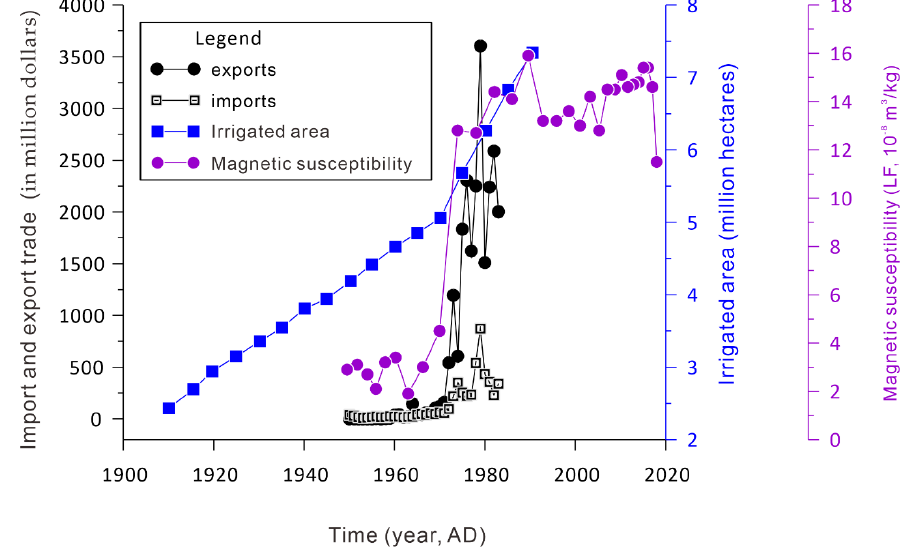
Figure 5. Comparison between sedimentological records and historical records of human activities. The data of magnetic susceptibility were from the sedimentary record of North Aral Sea in this study. The trade data between the former Soviet Union and the United States (million dollars) were from the unpublished source (Juhana Aunesluoma. East-West Trade and Détente. 28 February, 2005: http:// www.mv.helsinki.fi/home/miklossy/luennot/Aunesluoma.ppt). The data about surface area of irrigated Land (million hectares) in Aral Sea basin were from the reference [61].